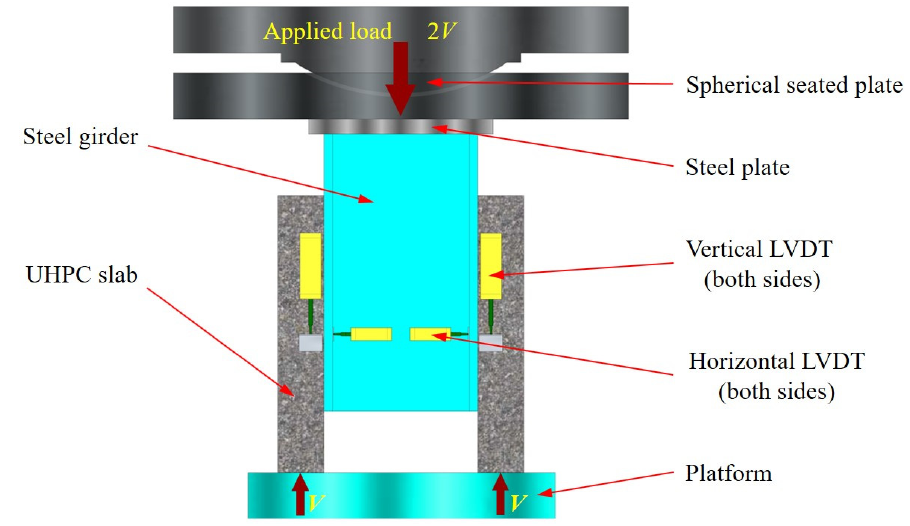
Figure 3. Test setup for push-out tests.